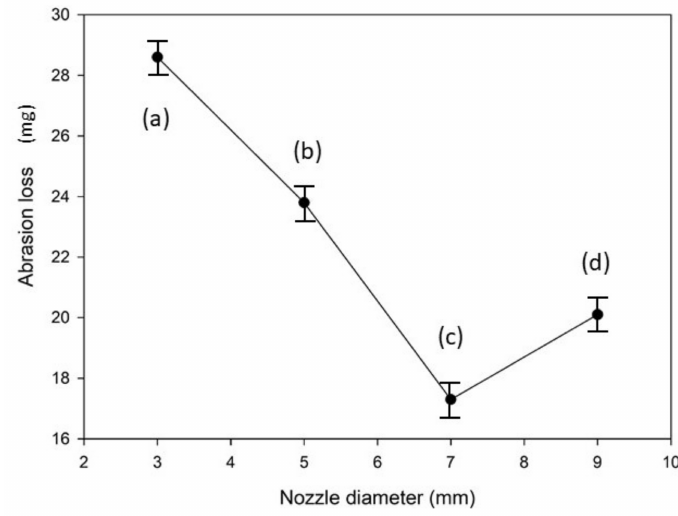
Figure 8. The abrasion losses of Ni–TiN coatings prepared at different nozzle diameters: ( a ) Nf = Φ 3 mm, ( b ) Nf = Φ 5 mm, ( c ) Nf = Φ 7 mm, ( d ) Nf = Φ 9 mm.